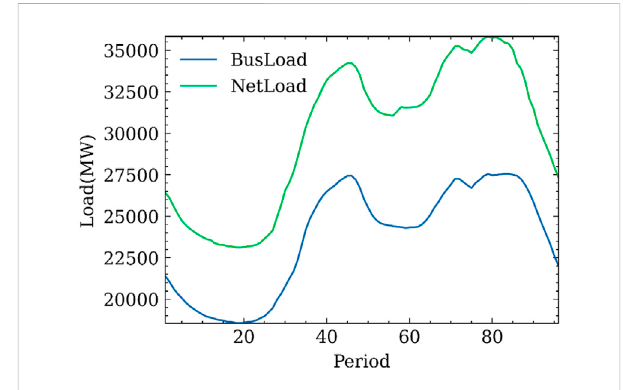
FIGURE 3 Net load and bus load of the whole system.